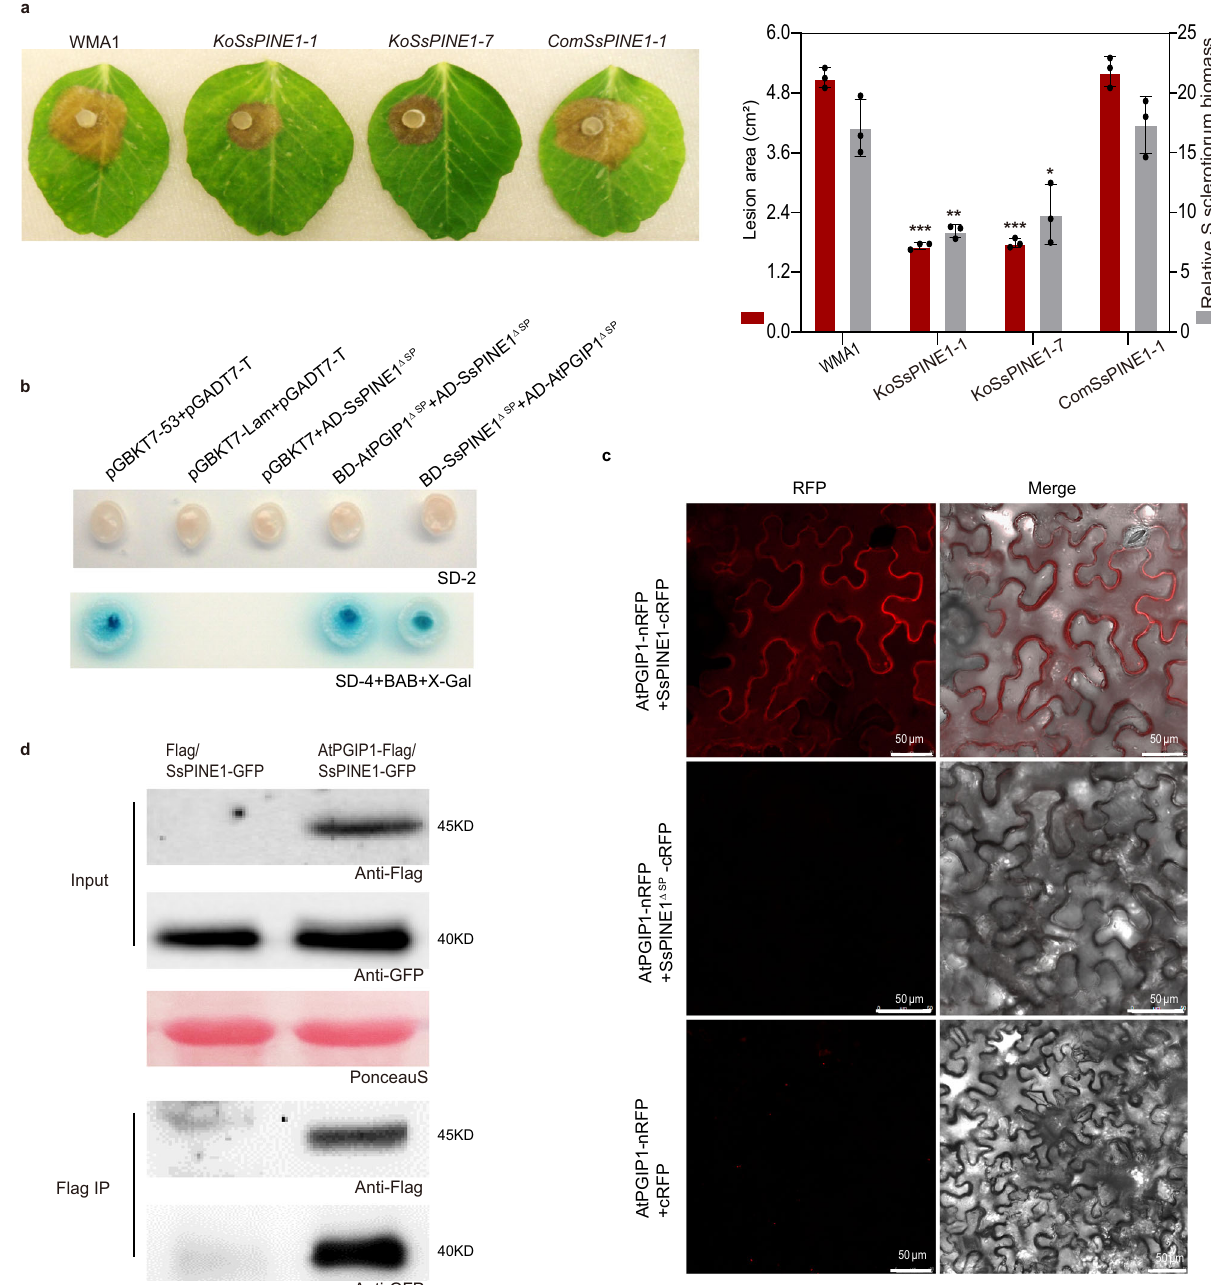
Fig. 1 Sclerotinia sclerotiorum SsPINE1 is required for full virulence and interacts with AtPGIP1. a Disease symptoms and disease quanti fi cation (lesion area and relative S. sclerotiorum biomass) on pea leaves caused by the wild-type strain WMA1, two SsPINE1 mutants KoSsPINE1-1 and KoSsPINE1-7 , and the complement strain ComSsPINE1-1 . Representative leaves were photographed 2 days post inoculation (dpi). Data represent mean ± s.d. of n = 3 biological replicates. *, ** and *** indicate signi fi cant difference from the wildtype WMA1 at p < 0.05, 0.01 and 0.001, respectively, in two-tailed t -test. The experiment was performed three times independently with similar results obtained. b Yeast two- hybrid assay showed SsPINE1 interacts with AtPGIP1 as either the bait or the prey. c Bimolecular fl uorescence complementation (BiFC) assay con fi rmed that SsPINE1 interacts with AtPGIP1 and the interaction requires signal peptide. N. benthamiana leaves were agroin fi ltrated with a mixture of Agrobacterium tumefaciens strains harboring constructs AtPGIP1-nRFP and SsPINE1-cRFP (top panel), AtPGIP1-nRFP and SsPINE1 Δ SP -cRFP (middle panel), and the negative control AtPGIP1-nRFP and cRFP (lower panel). The RFP fl uorescence was monitored at 2 days post-agroin fi ltration using confocal laser scanning microscope. Representative images are shown. The experiment was performed three times with similar results obtained. d Co-immunoprecipitation (Co-IP) assay showed that SsPINE1 is associated with AtPGIP1 in planta . Co-IP constructs AtPGIP1-Flag and SePINE1-GFP were transiently expressed in N. benthamiana leaves. Immunoprecipitations were performed with anti-Flag agarose (Flag IP), and SsPINE1 was detected in the immuno-precipitates using anti-GFP antibody. Representative images are shown. The experiments were performed three times independently with similar results obtained. Source data are provided as a Source data fi